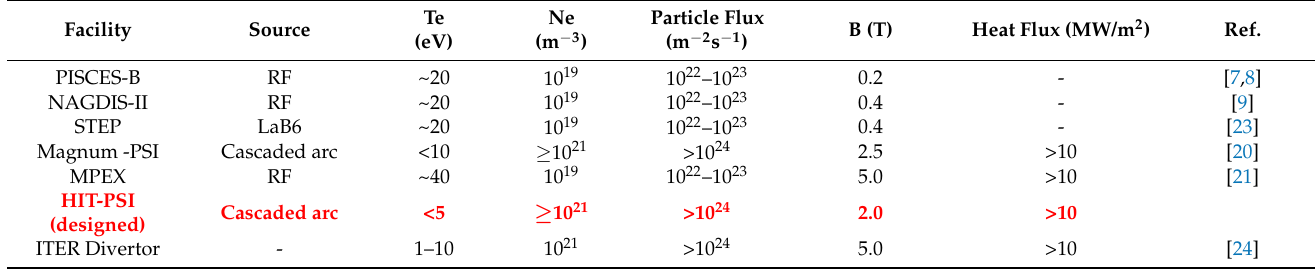
Table 1. Parameters of ITER required and existing/designed devices.